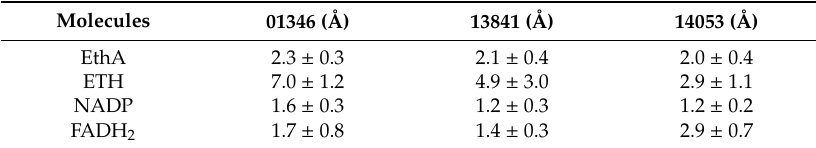
Table 2. Root mean square deviations (Å) of EthA systems.